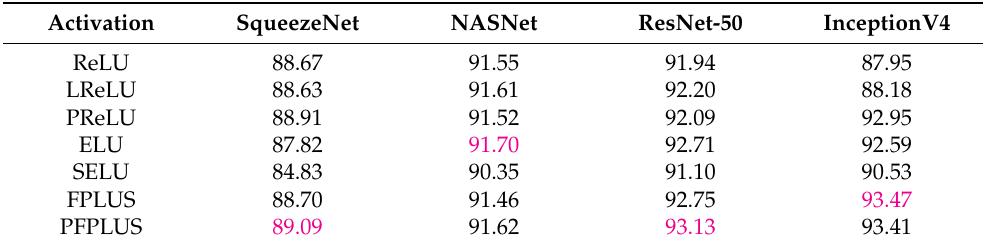
Table 5. Accuracy rate (%) on validation set of CIFAR-10 for each network with different activa- tion functions.